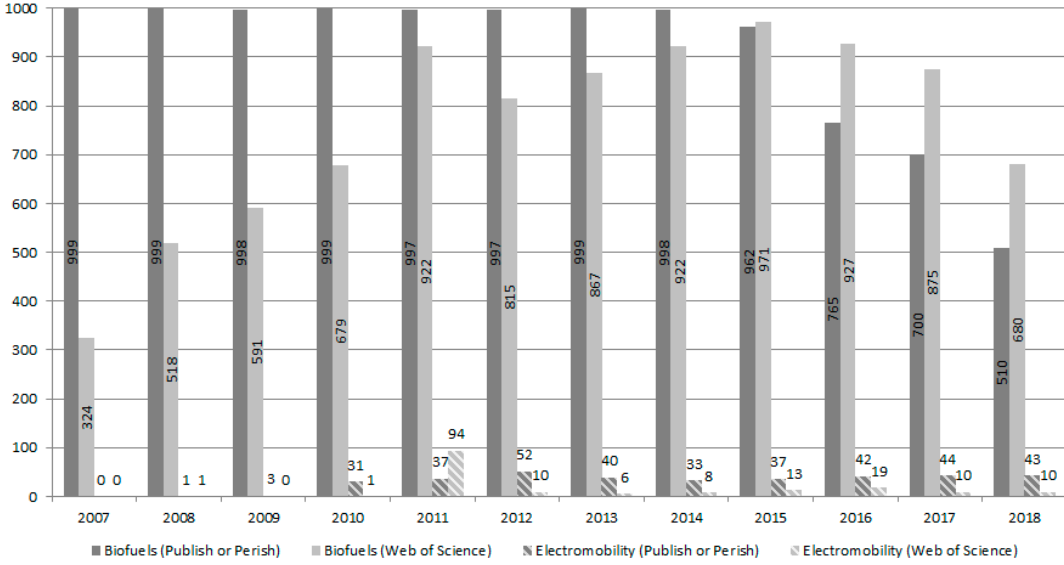
Figure 1. Scientific publications about biofuels and electromobility in the past decade.